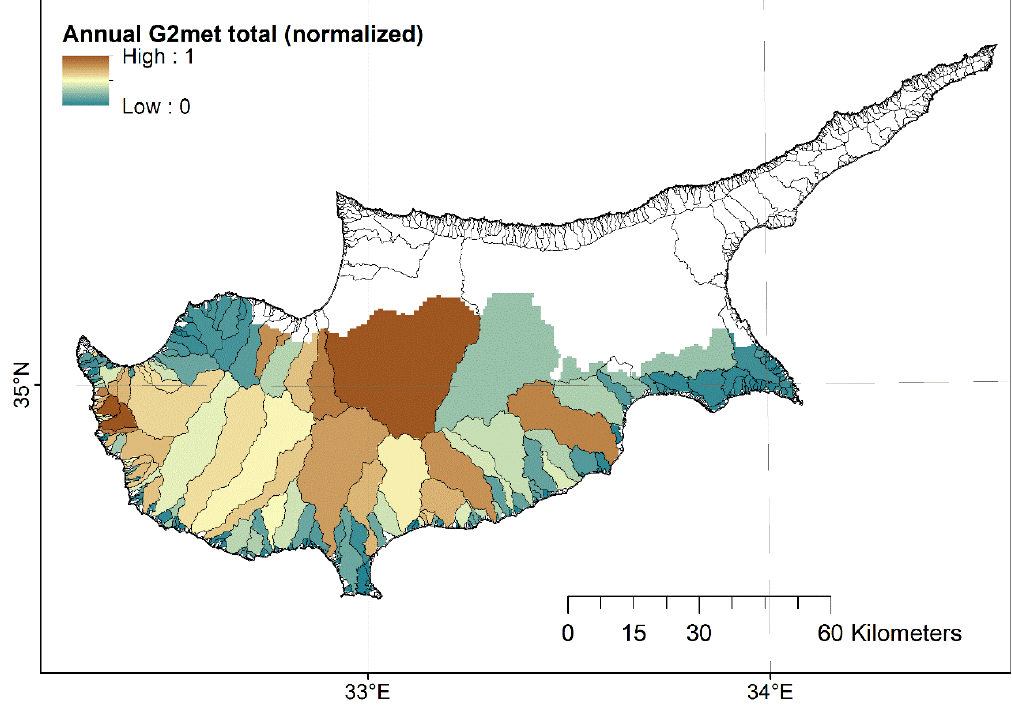
Figure 9. Choropleth map of annual G2 met index for total risk per basin (value ranging: histogram equalization; mean value: 142.8; normalized mean value: